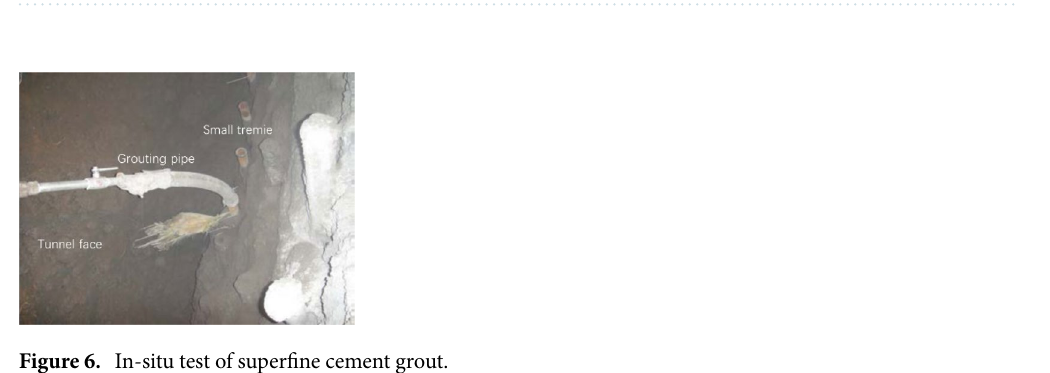
Figure 5. Layout of grouting pipes in vault area.